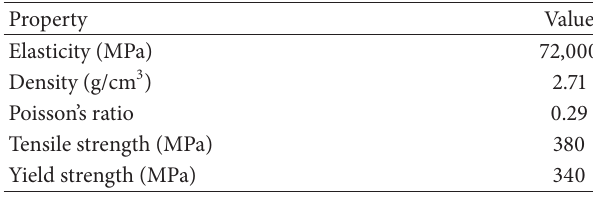
Table 3: Material properties of Al6082M.